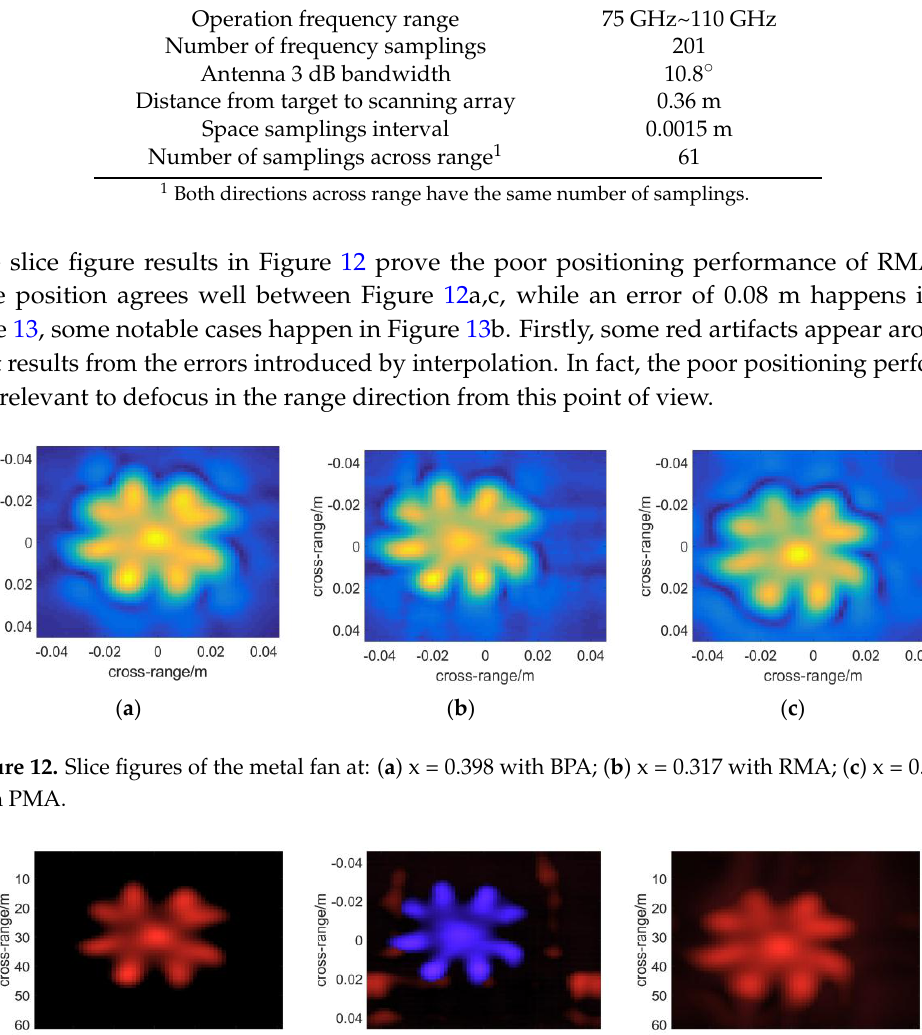
Table 3. The parameters used in the experiment.